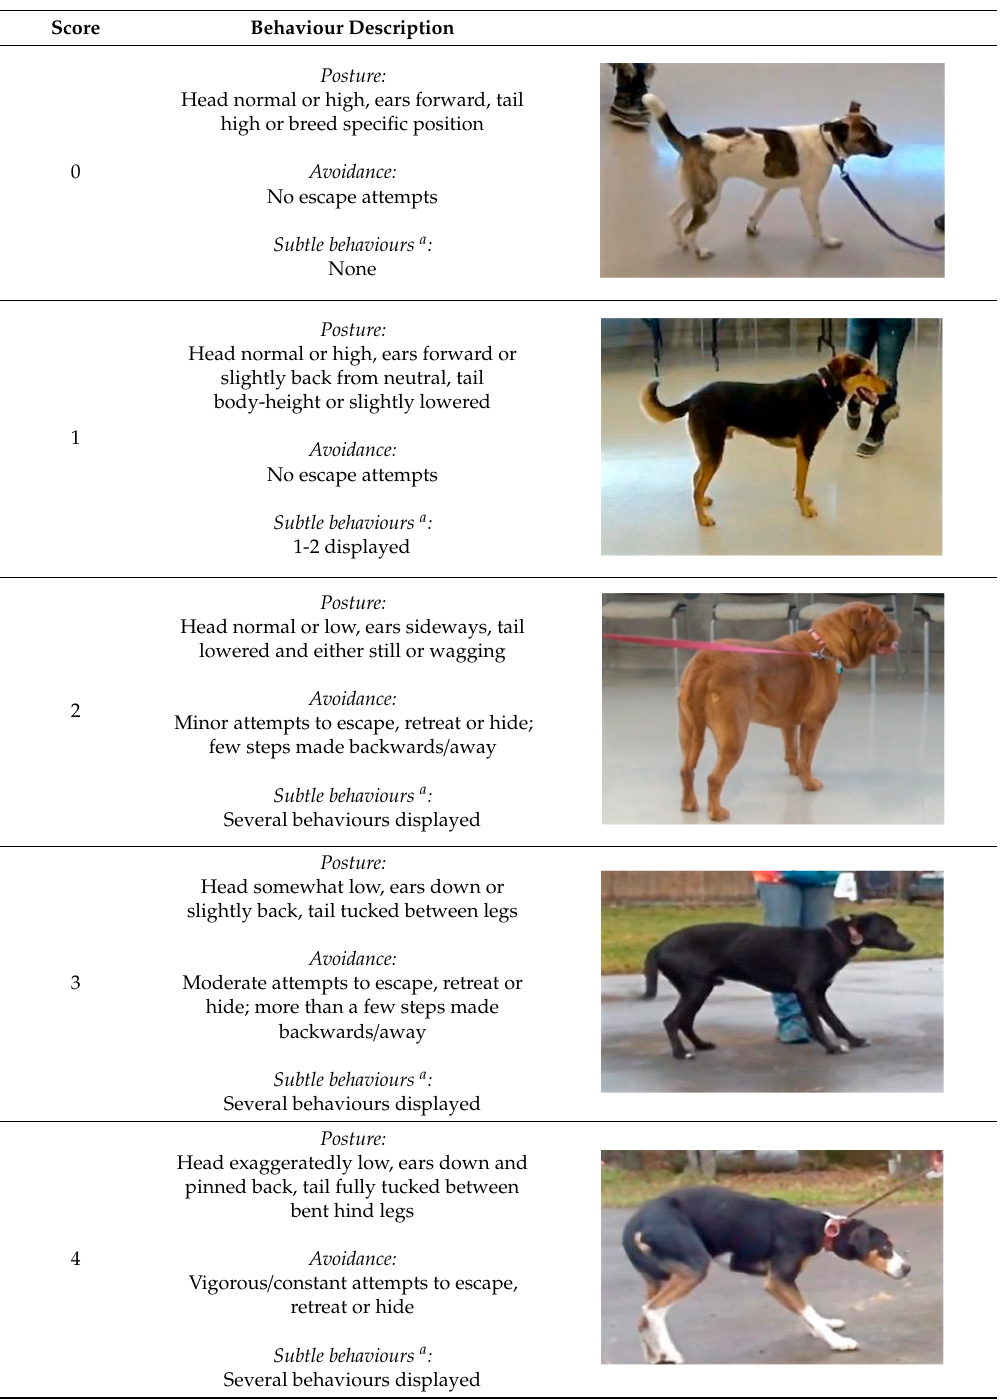
Table 4. Method for subjective scoring of dog fear on a 5-point scale ranging from 0 (no fear) to 4 (extreme fear). This scale was used by participants during preliminary recruitment and by the investigator for assessing overall fear scores during clinic entrance and examination.